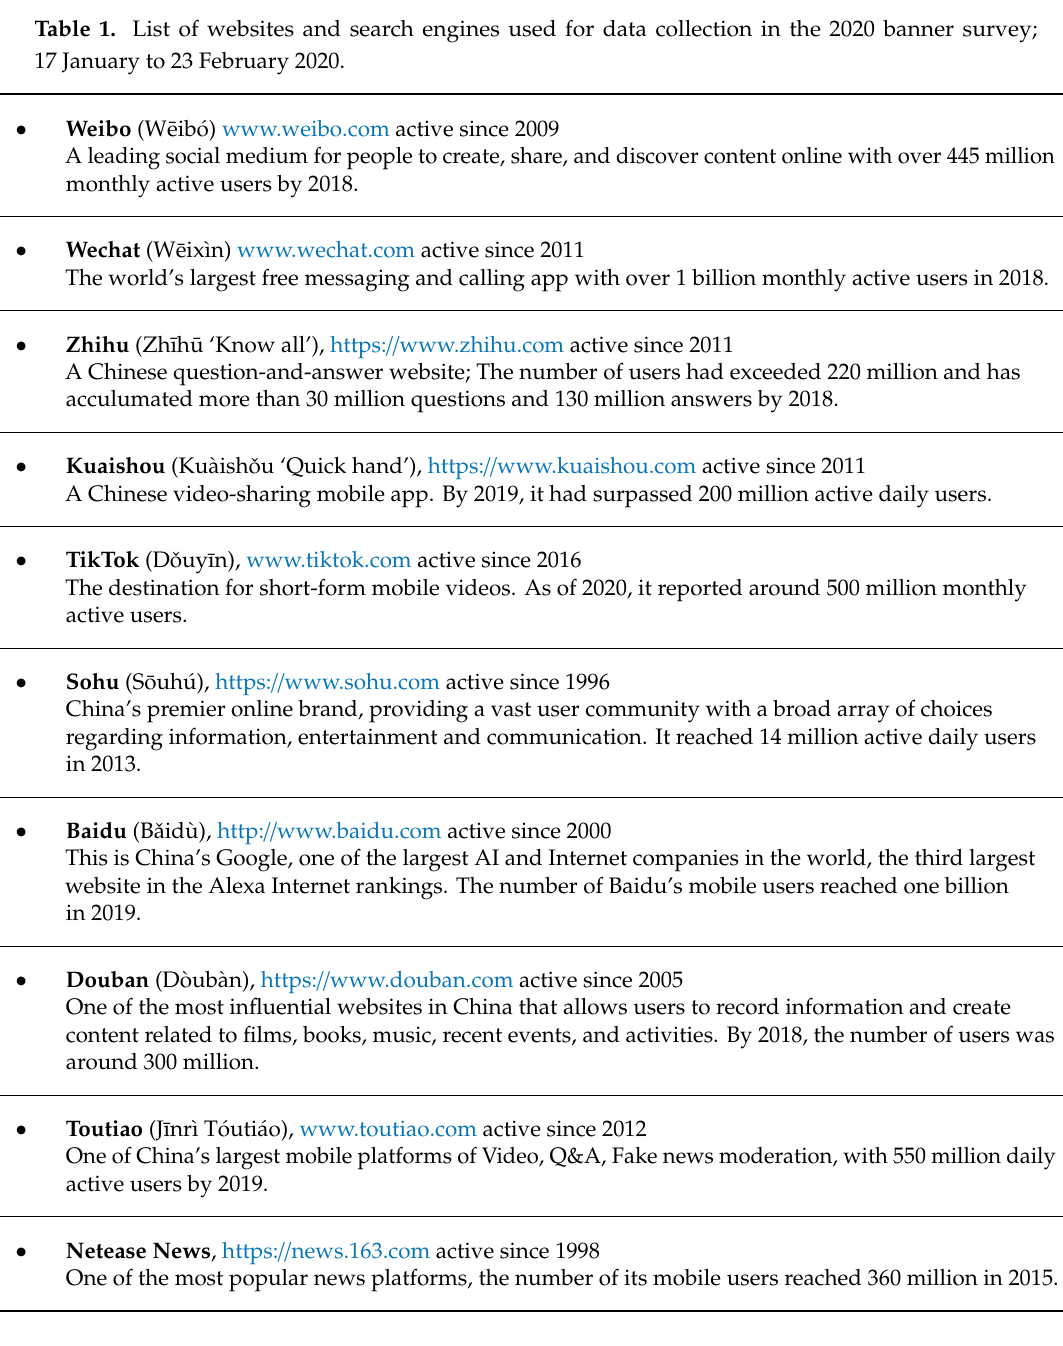
Table 1. List of websites and search engines used for data collection in the 2020 banner